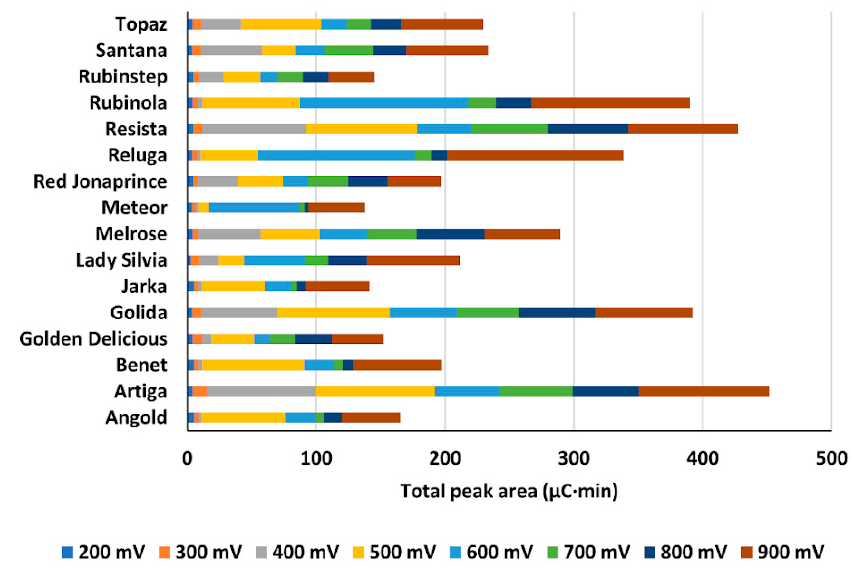
Figure 2. Contributions to total peak area obtained using CD at single potentials ranging from 200–900 mV.